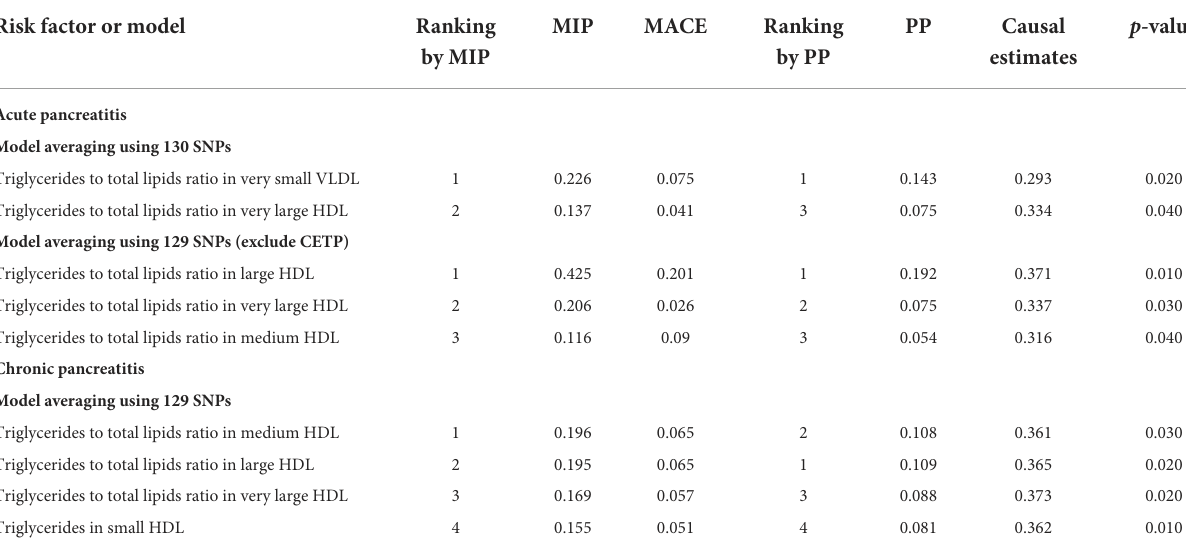
TABLE 1 Ranking of triglycerides related traits for acute pancreatitis and chronic pancreatitis using MR-BMA. Risk factor or model Ranking